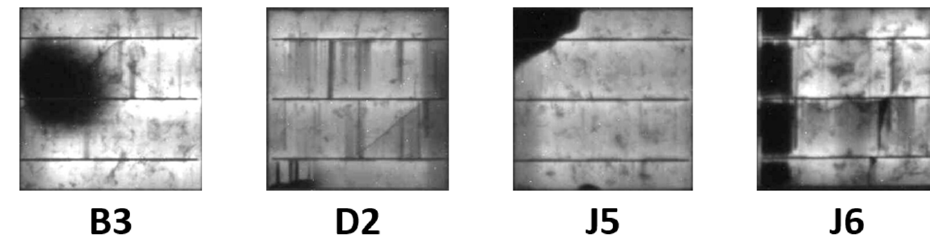
Figure 17. Examples for several solar cell defects.